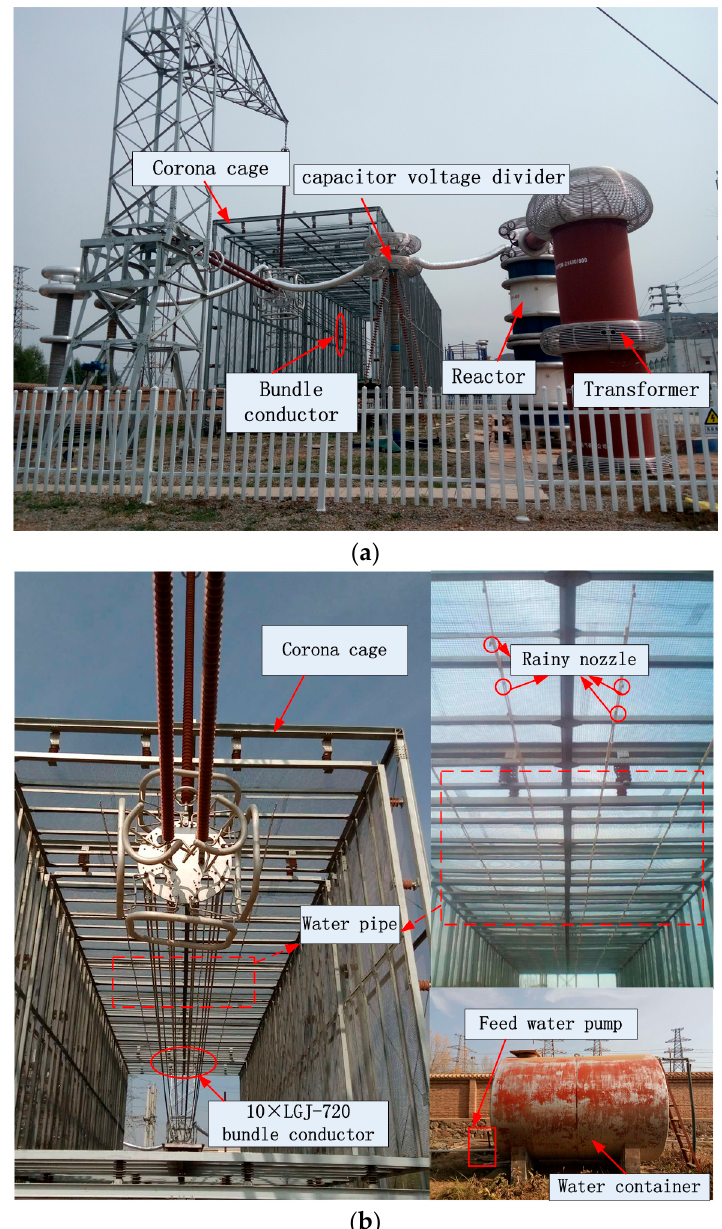
Figure 1. General layout of experimental platform. ( a ) Corona cage; and ( b ) Artificial rainfall system.